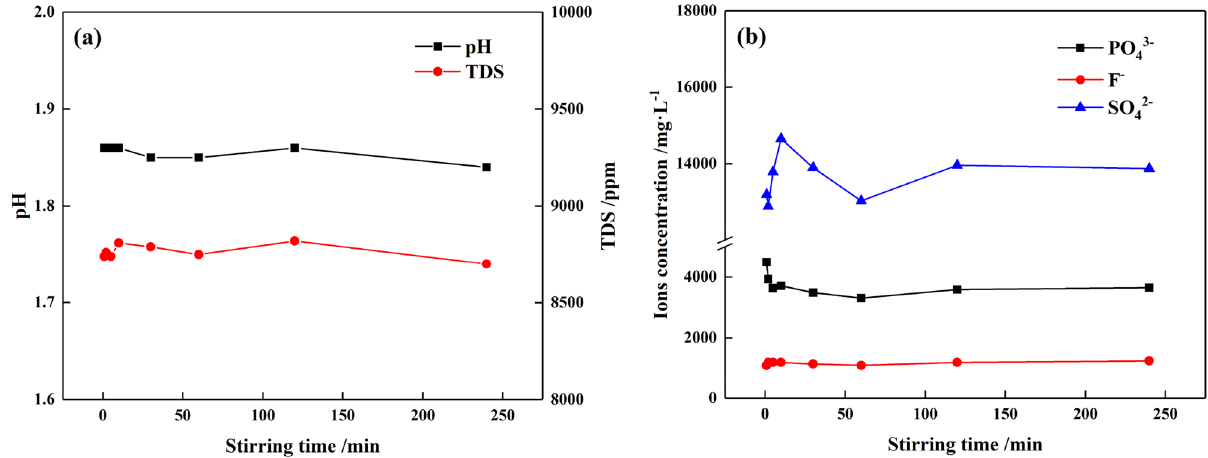
Figure 2. Variations of PG with different stirring times: ( a ) pH value and TDS, ( b ) concentrations of PO 43− , F − and SO 42− .